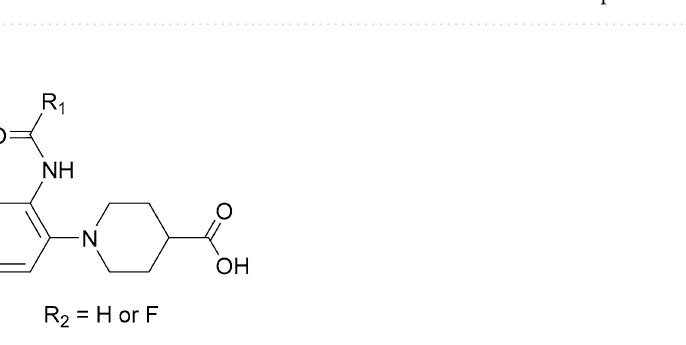
Table 2. Hit compounds in TR-FRET assays for Keap1/Nrf2. a Inhibition rates (%) of the compounds at are shown as the rank of the prediction scores. The ranks that satisfied the selecting threshold ( i.e. , ≤ 1000) are marked with asterisks. c Structural similarities to the closest known Keap1/Nrf2 PPI inhibitors are shown.